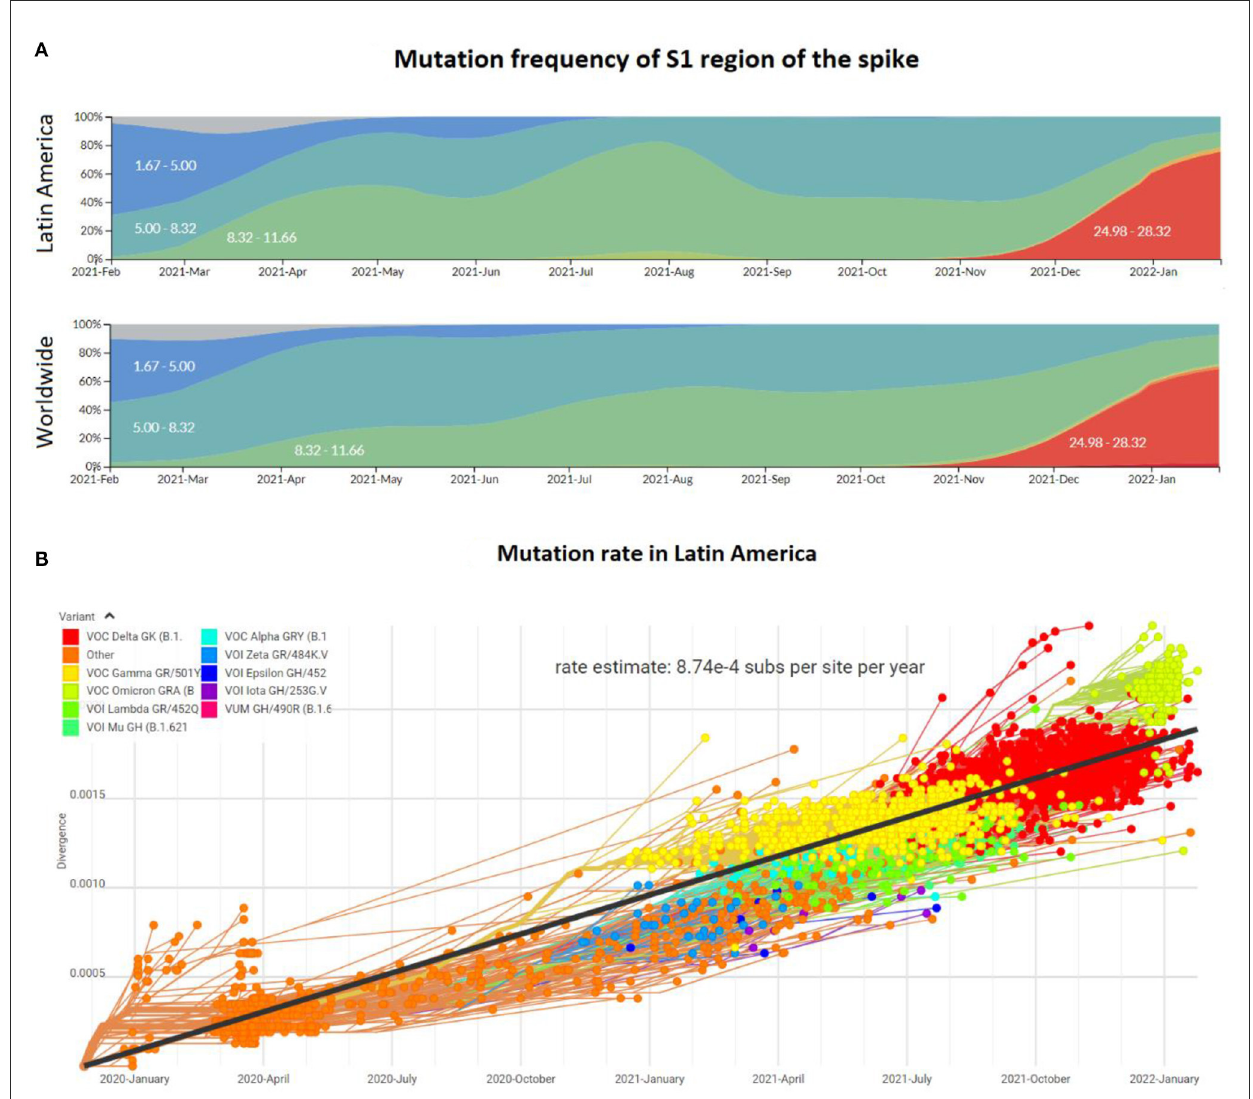
FIGURE3 Mutation profile of the SARS-CoV-2 genome in Latin America and worldwide from the beginning of the pandemic to January 2022. (A) Mutation frequency in the region S1 encoding the spike protein of the SARS-CoV-2 viral genome. Colors represent the intervals for the absolute mutation number. (B) Mutation rate of the SARS-CoV-2 genomes during the pandemic, including distinct genotypes (colors) and the approach to estimate consensus rate (black